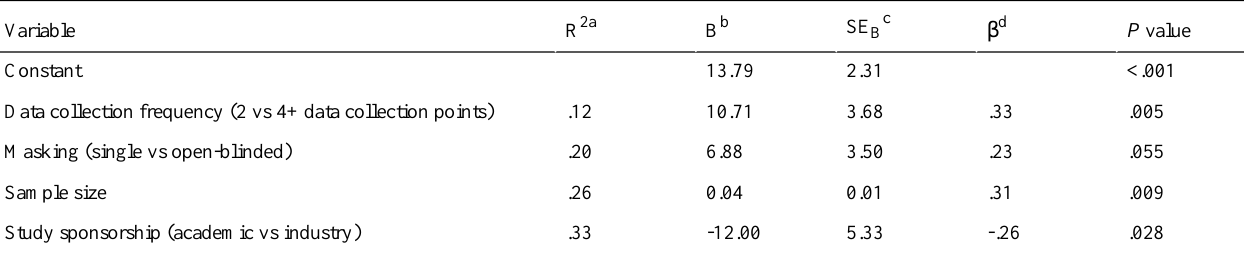
Table 6. Multiple linear regression model of predictors for study